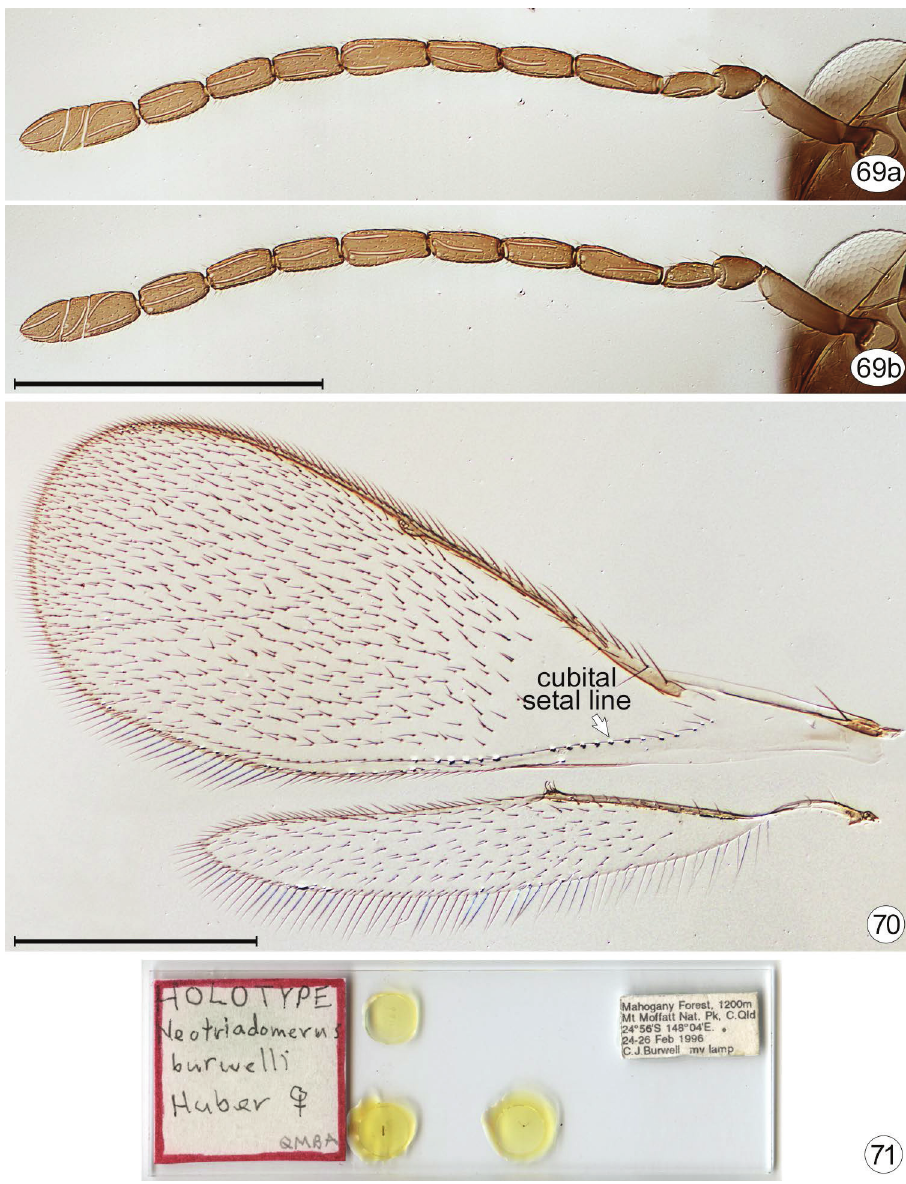
Figures 69–71. Neotriadomerus burwelli , holotype. 69a right antenna, medial 69b same antenna, lateral (as seen through antenna) 70 wings 71 holotype slide. Scale bar = 300